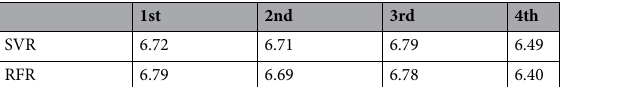
Table 4. Regression results [Mw] for both considered algorithms applied to the four feature sets extracted from the study case signal.